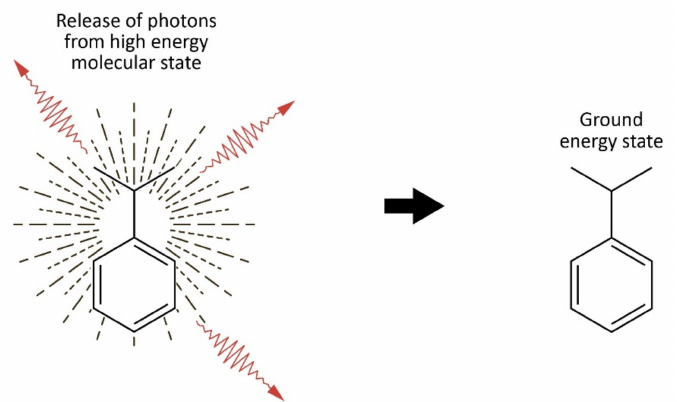
Figure 3. Odorant molecule in high energy state following IET ( left ). Emission of three photons as the odorant molecule decays to the ground energy state ( right